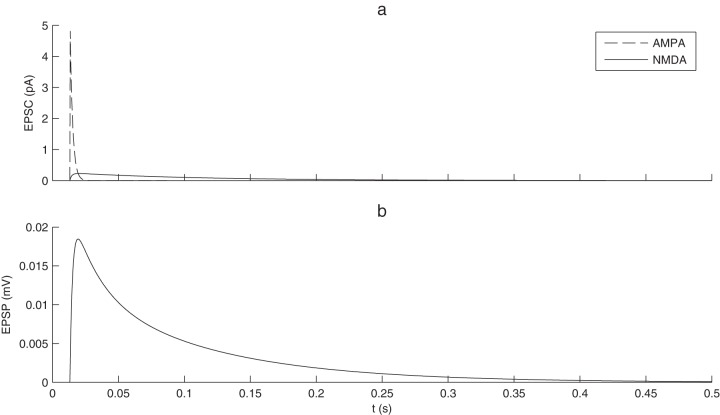
Excitatory postsynaptic currents and potentials.(a) NMDA and AMPA current dynamics after the arrival of one presynaptic spike. NMDA timescales are much longer. (b) Resulting EPSP.